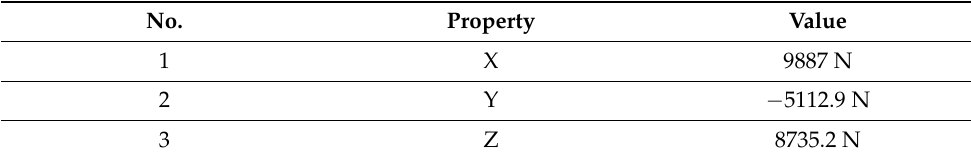
Table 4. Loading vale extracted from Global FEA.